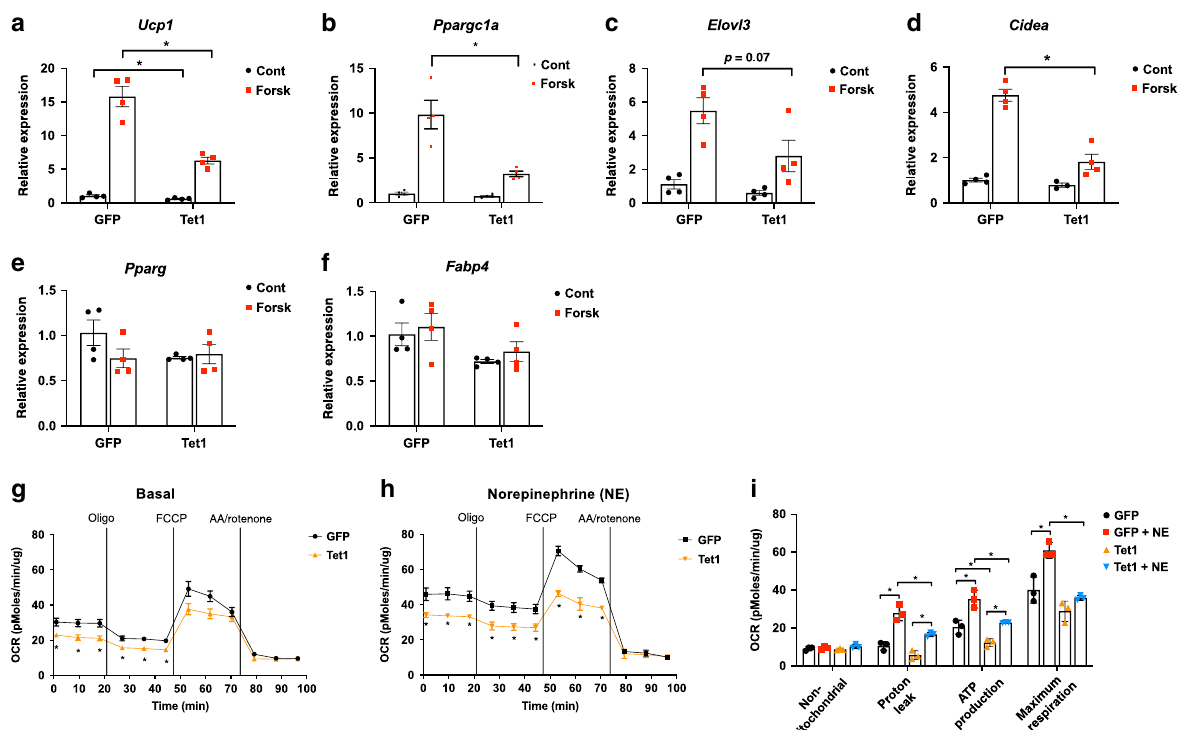
Fig. 3 Tet1 gain-of-function in vitro suppresses thermogenesis in beige adipocytes. a – f Differentiated beige adipocytes were transduced with lentiviral expression plasmids for Tet1 and GFP. The basal- and forskolin-stimulated levels of key adipocyte thermogenic gene transcripts were measured by qPCR ( n = 4 per group. Data are expressed as means ± SEM. *denotes p < 0.05, determined by two-tailed Student ’ s t test and two-way ANOVA followed by Bonferroni post-hoc testing). g , h Basal and norepinephrine (NE)-stimulated mitochondrial respiration under various drug treatments was measured in Tet1 overexpression and GFP beige adipocytes ( n = 3 per group. Data are expressed as means ± SEM. *denotes p < 0.05, determined by two-tailed Student ’ s t test and one-way ANOVA). (Oligo; Oligomycin, AA; antimycin A). i Shown are the various components of oxygen consumption rates with and without NE stimulation from g , h . ( n = 3 per group. Data are expressed as means ± SEM. *denotes p < 0.05, determined by two-tailed Student ’ s t test and two-way ANOVA followed by Bonferroni post-hoc testing). Source data are provided as a source data fi